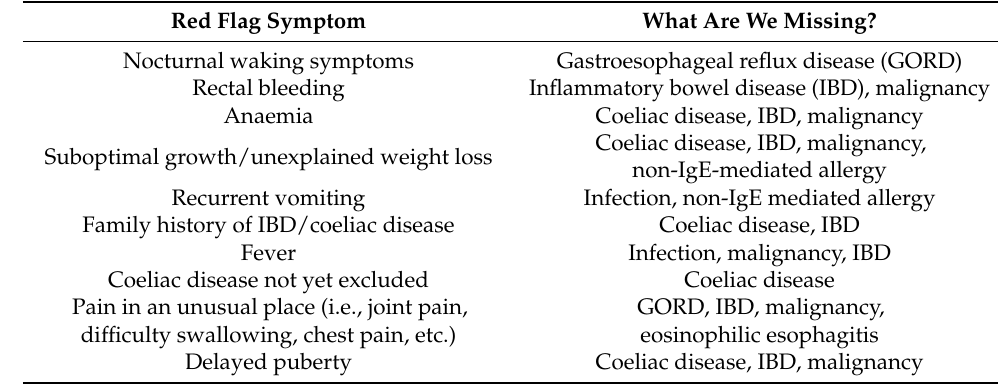
Table 4. Red flags to consider during assessment of the paediatric GI patient. Red Flag Symptom What Are We Missing? Nocturnal waking symptoms Gastroesophageal reflux disease (GORD) Rectal bleeding Inflammatory bowel disease (IBD), malignancy Anaemia Coeliac disease, IBD, malignancy Coeliac disease, IBD, malignancy, Suboptimal growth/unexplained weight loss non-IgE-mediated allergy Recurrent vomiting Infection, non-IgE mediated allergy Family history of IBD/coeliac disease Coeliac disease, IBD Fever Infection, malignancy, IBD Coeliac disease not yet excluded Coeliac disease Pain in an unusual place (i.e., joint pain, GORD, IBD, malignancy, difficulty swallowing, chest pain, etc.) eosinophilic esophagitis Delayed puberty Coeliac disease, IBD,